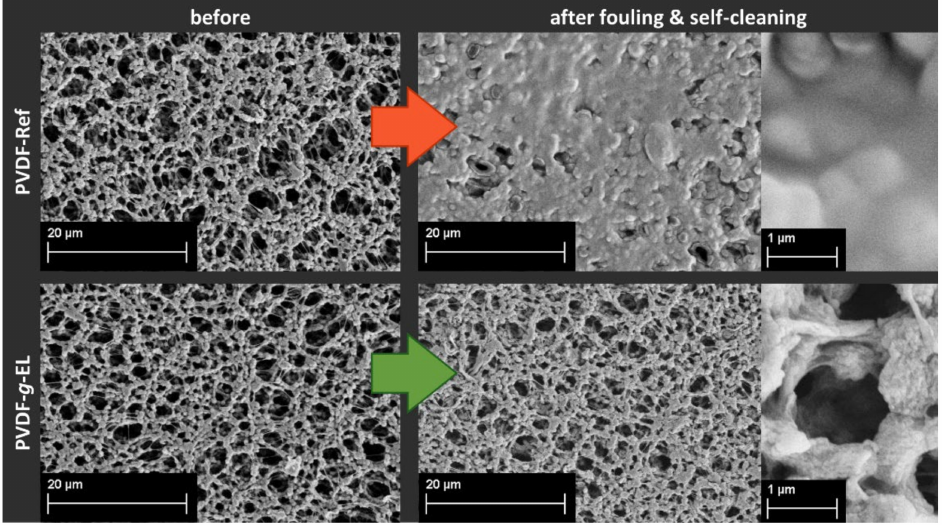
Figure 4. SEM images of pristine PVDF-Ref and modified PVDF- g -EL before and after the first fouling and self-cleaning